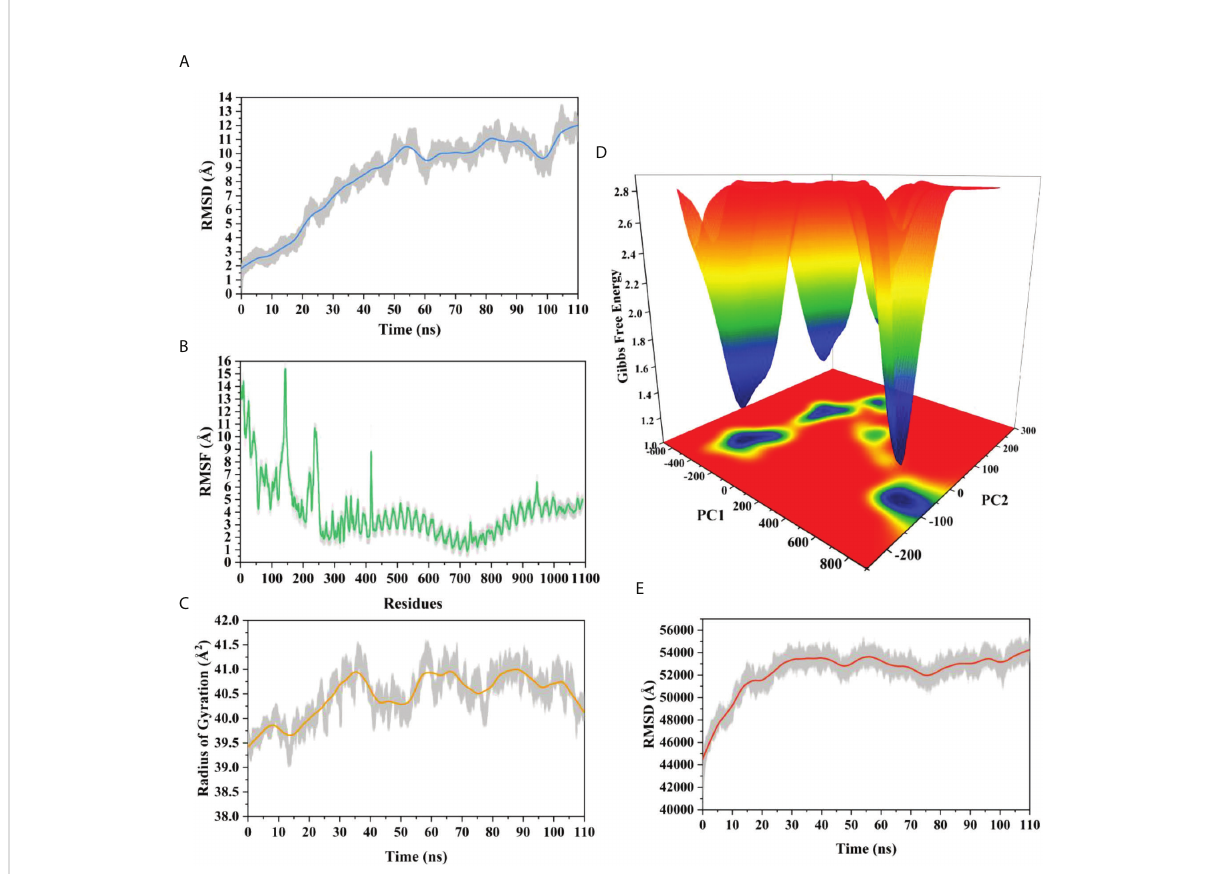
FIGURE 9 Molecular dynamics simulation of Neo-4 and TLR-3 complex at 110ns (A) Root means square deviation (RMSD) plot of the complex, representing mild fl uctuations (B) The Root means square fl uctuation (RMSF) plot of the docked complex (C) The Radius of Gyration plot of the docked complex (D) Free energy landscapes (FELs) of the docked complex. High, intermediate, and low/stable energy states are shown in red, yellow/green, and light-to dark blue color in the graph, respectively (E) Alterations in Solvent-Accessible Surface Area (SASA) pro fi le of the docked complex during the simulation.